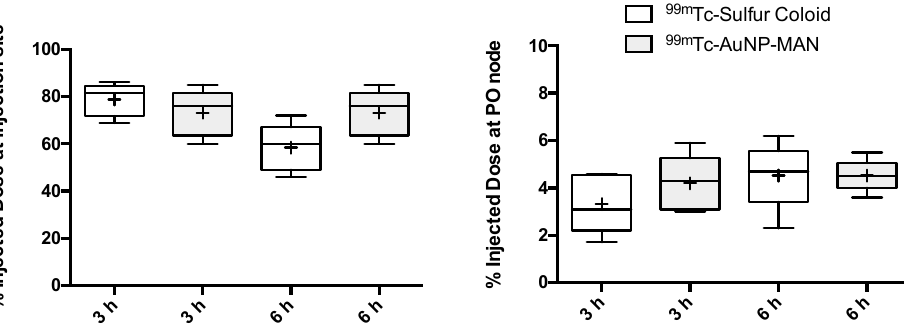
Figure 7. A box and whisker plot showing the results of the percentage of injected dose at the injection site (left) and popliteal node (right) at 3 and 6 h after the injection of either 99m Tc-Sulfur colloid or 99m Tc-AuNPs-MAN 48h . Boxes extend from 1st to 3rd quartiles; thick lines and + symbols inside boxes represent the median and mean (n = 5), respectively; whiskers go from the smallest to the largest values in each group and there were no outliers. No statistical difference was observed after ANOVA.